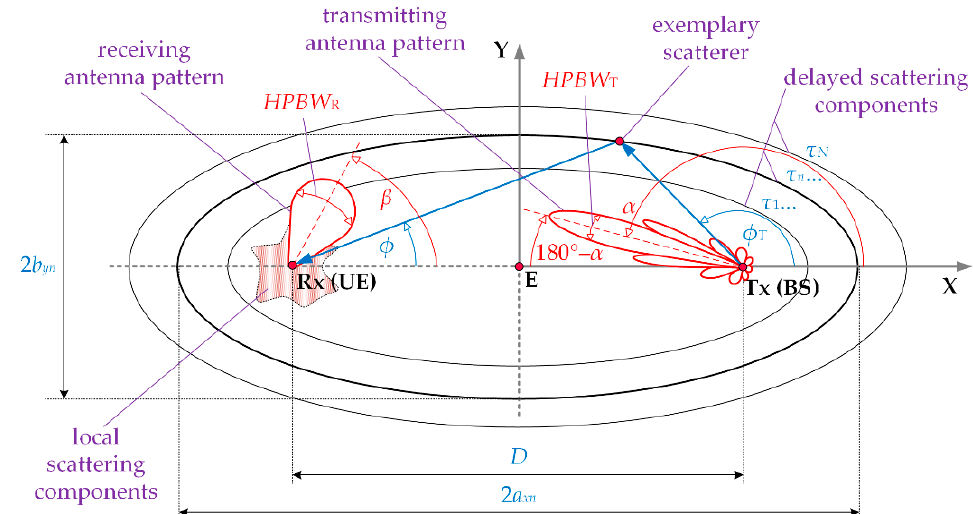
Figure 1. Scattering geometry of the multi-elliptical propagation model (MPM) in the azimuth plane.